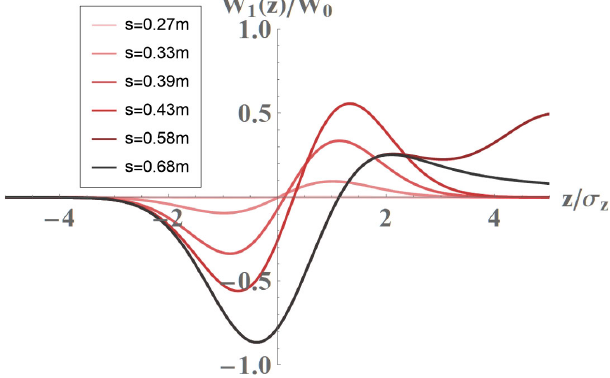
12. Evolution of W ð z Þ inside drift D1 in beamline B. The curves are theory prediction using Eq. (104), and the dots are from Bmad